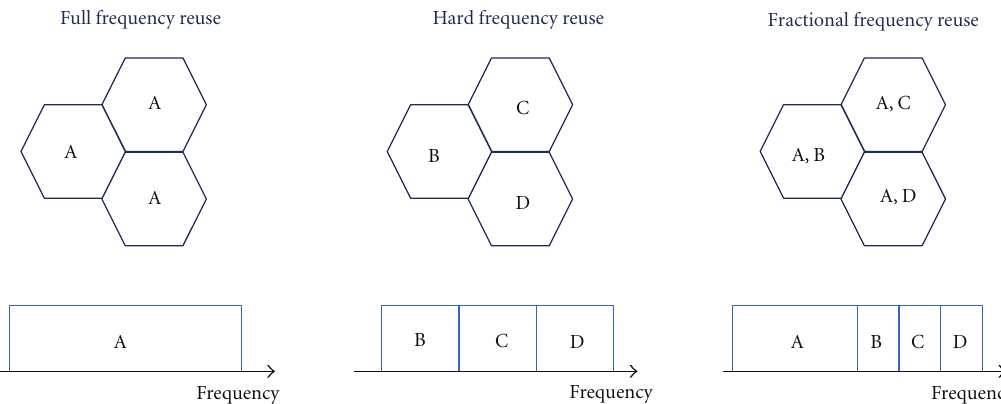
Figure 2: Illustration of Full-FR, HFR, and FFR for the simple case of base staions using omnidirectionall antennas.